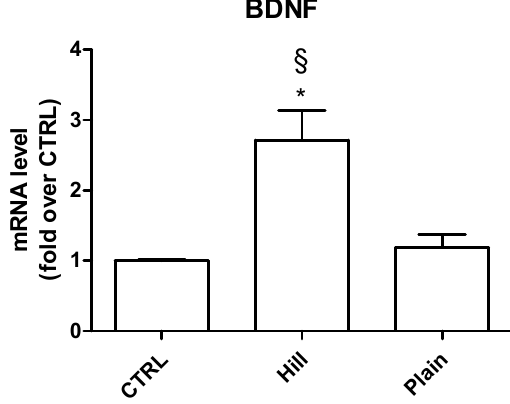
Figure 5. Expression of BDNF in SH-SY5Y cells treated with the extracts. Cells were treated with hill and plain extracts (10 µ g/mL) for 24 h. Real time-PCR was performed to detect BDNF mRNA levels. Data are expressed as relative abundance compared to untreated cells. Each bar represents mean ± SEM of three independent experiments. Data were analyzed with one-way ANOVA followed by the Bonferroni’s test. * p < 0.05 vs. CTRL; § p < 0.05 vs. plain.